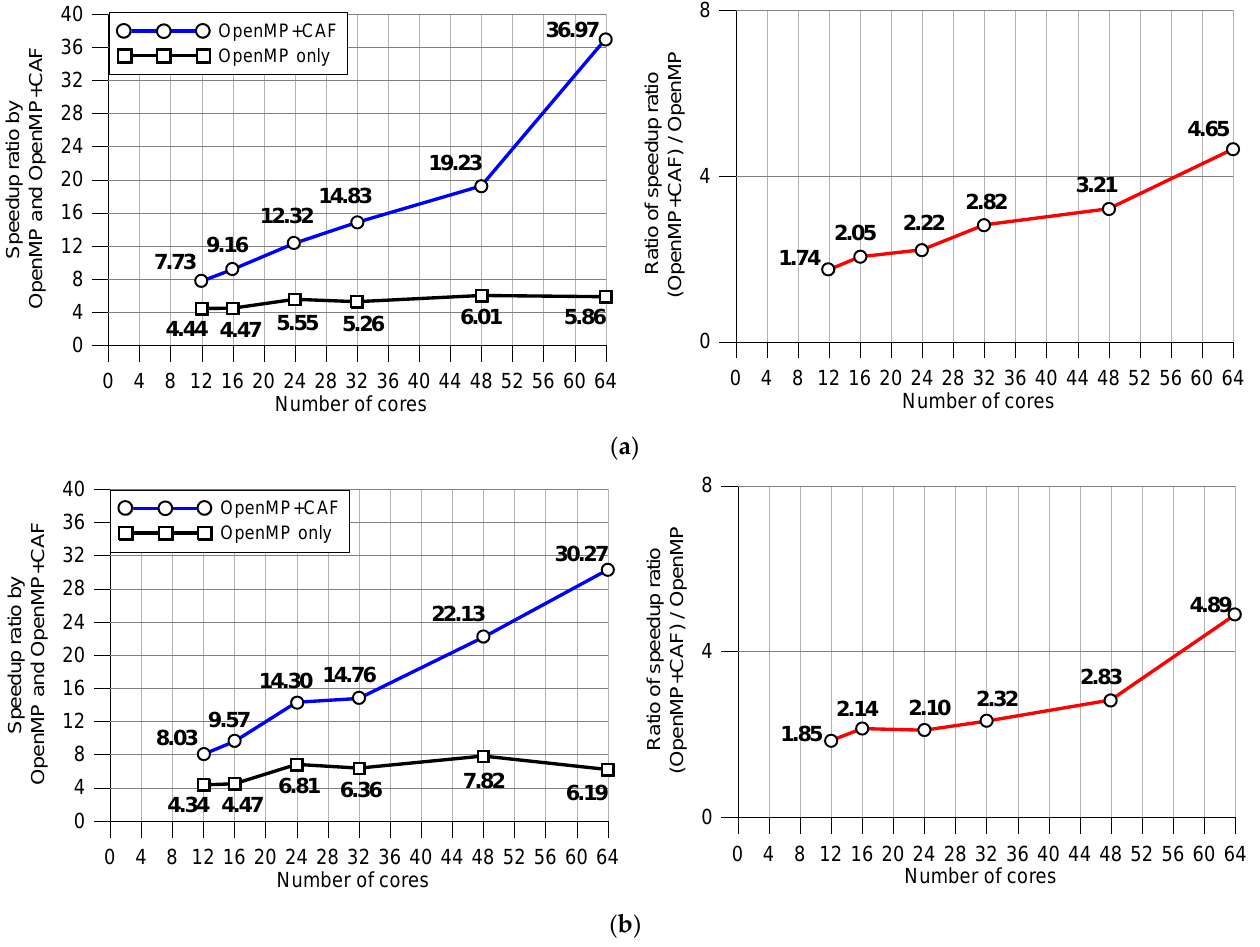
Figure 8. Maximum speedup ratios for OpenMP+CAF and OpenMP using dual-CPU computer systems: ( a ) Shallow foundation example; ( b ) Deep foundation example.